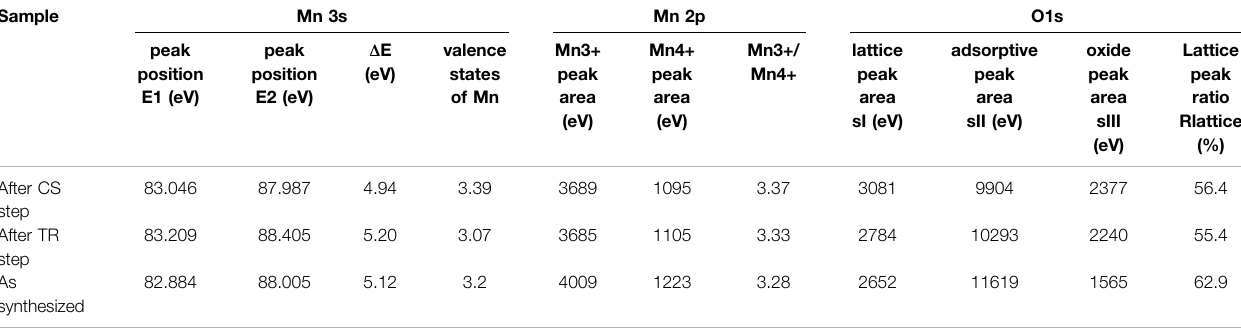
TABLE 3 | Mn valence v Mn for the synthesized sample (as-prepared sample), thermally-reduced sample obtained after the TR step, and the oxidized sample obtained after the CS step. The values were estimated from Mn 3s, and Mn 2p x-ray photoelectron